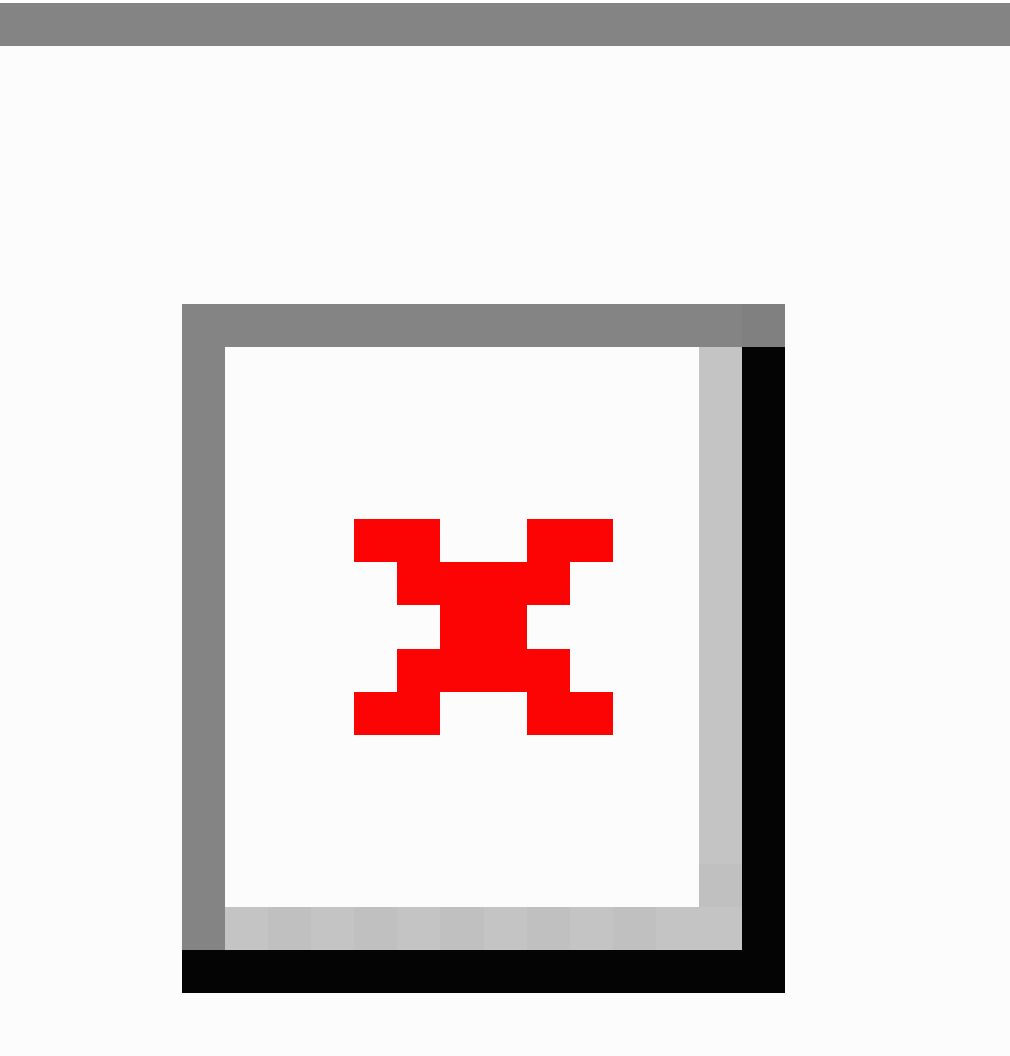
Figure 7. Obtained retrieval results in ranked order (1st to 24th best matches) for the C16 input query frame using both a class prediction–based method and a method without class